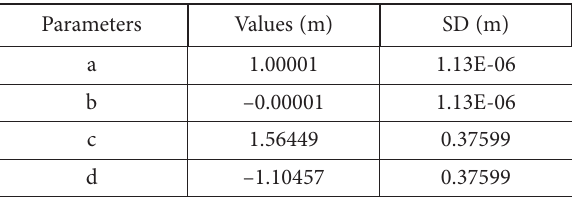
Table 2. 2D conformal model transformation parameters